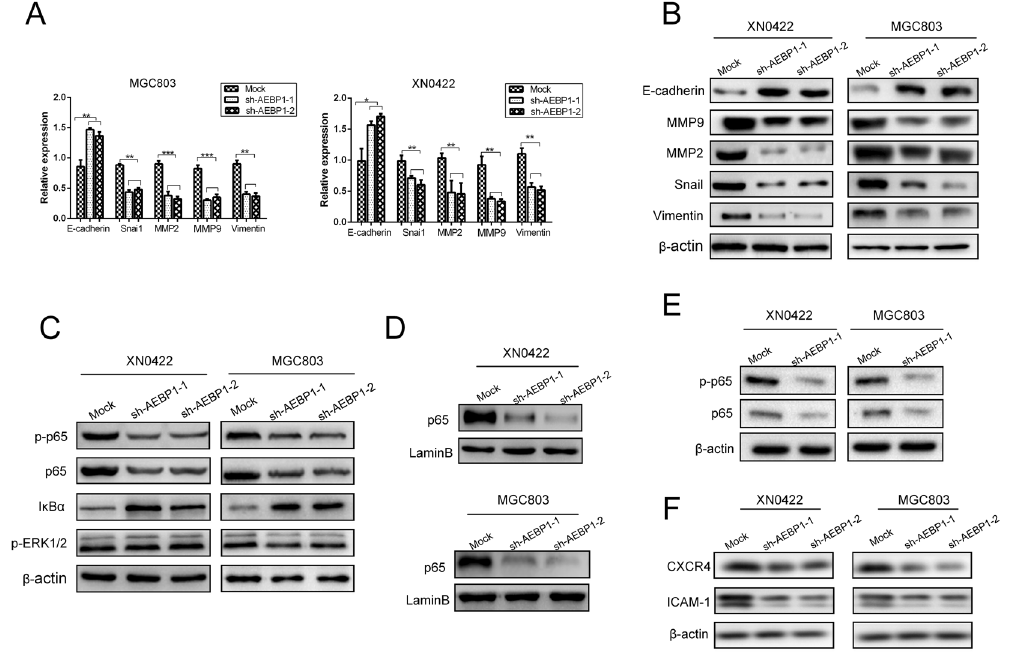
Figure 6. Silencing AEBP1 results in the inhibition of epithelial-mesenchymal transition (EMT) by downregulating the NF- κ B pathway. ( A ) qRT-PCR and ( B ) Western blotting analyses of EMT-related markers (E-cadherin, MMP2, MMP9, snail and vimentin) in AEBP1-knockdown and mock cells; * P < 0.05; ** P < 0.01, *** P < 0.001. ( C ) Protein levels of p65, p-p65, I κ B α and p-ERK1/2 in AEBP1-knockdown and mock cells. ( D ) Nuclear protein expression of NF- κ B p65 in AEBP1-knockdown and mock cells. ( E ) Western blotting analyses of p65 and p-p65 expression in xenograft tumors derived from the AEBP1-knockdown and mock MGC803 and XN0422 cells. ( F ) Protein levels of two NF- κ B downstream targets (CXCR4 and ICAM1) in AEBP1-knockdown and mock cells. The western blots were derived under the same experimental conditions from the same cell lysates; the original full-length Western blot images are shown in Supplementary Fig.